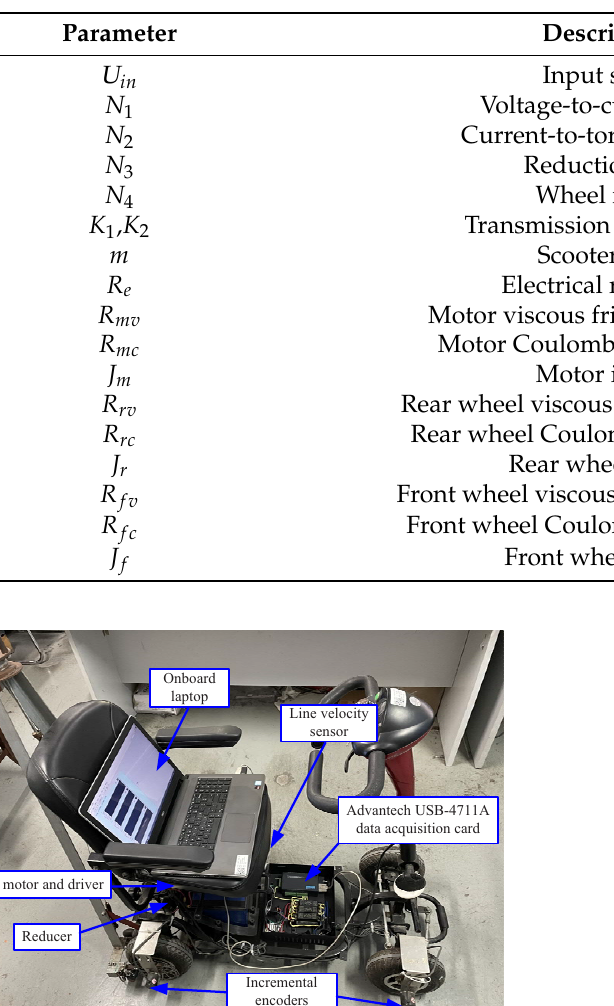
Table 1. Nomenclatures.